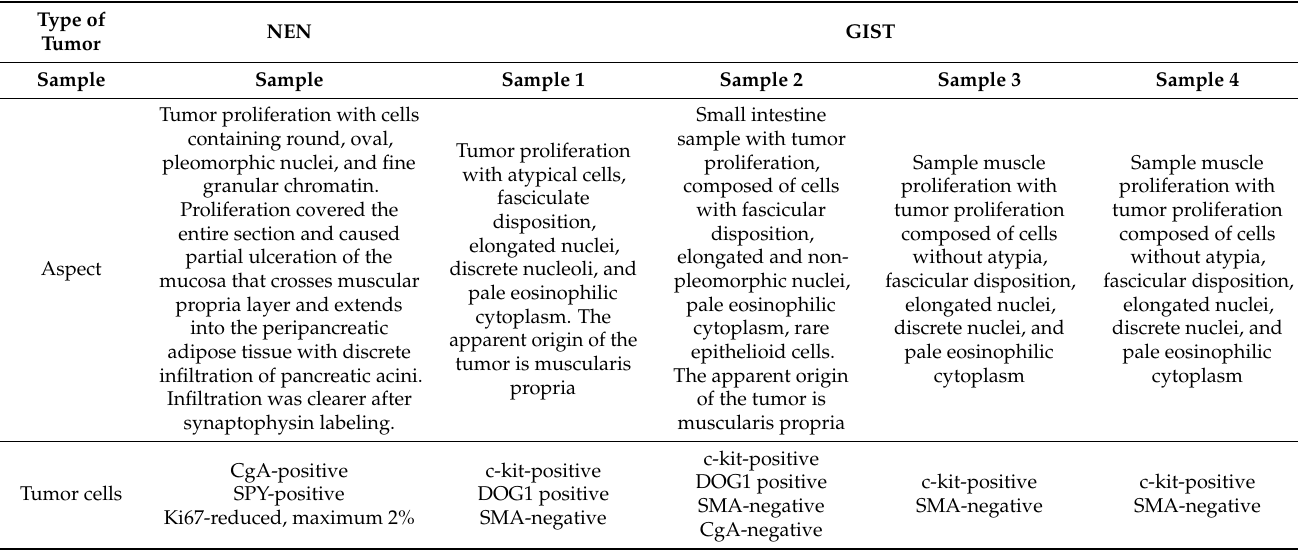
Table 1. Characteristics of the NEN and GISTs samples